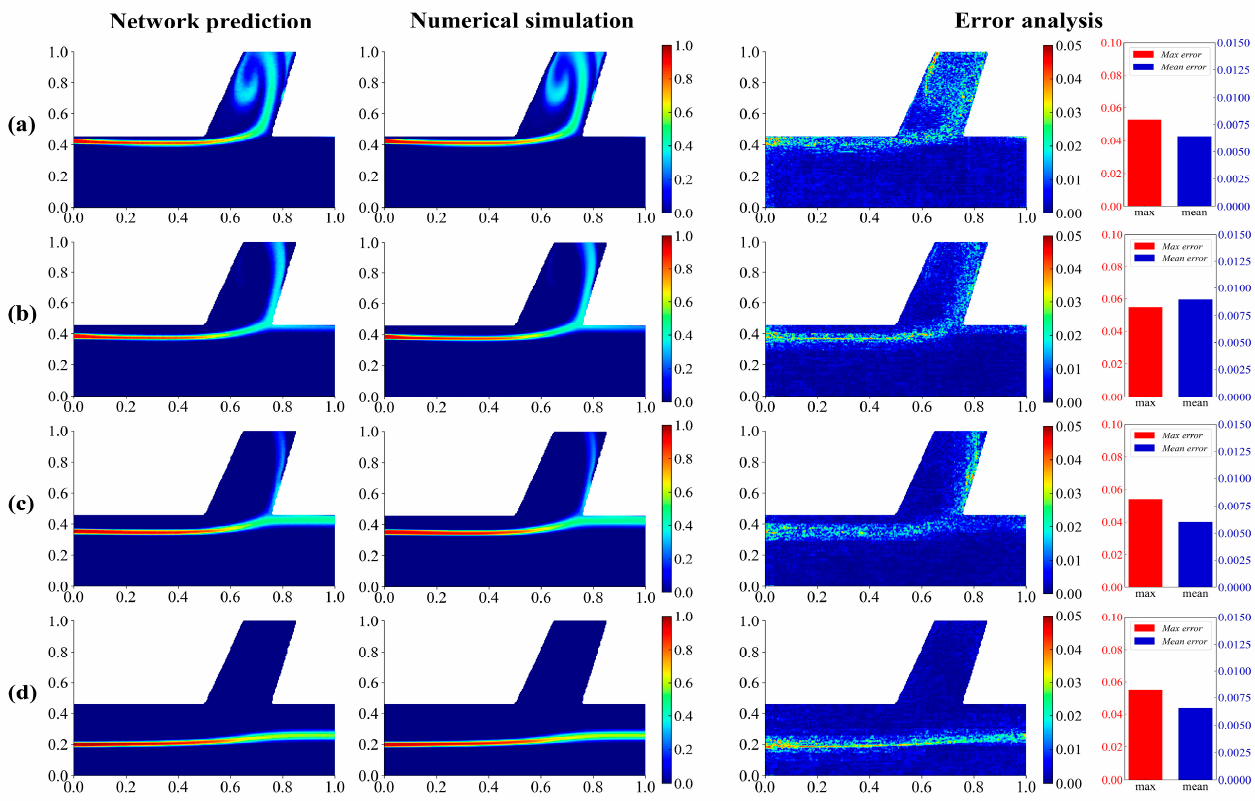
Figure 6. Drug concentration field and error distribution in the bifurcated vessel: ( a – d ) are respec- tively 0.8 R, 0.7 R, 0.55 R, − 0.14 R from the central axis of the blood vessel.